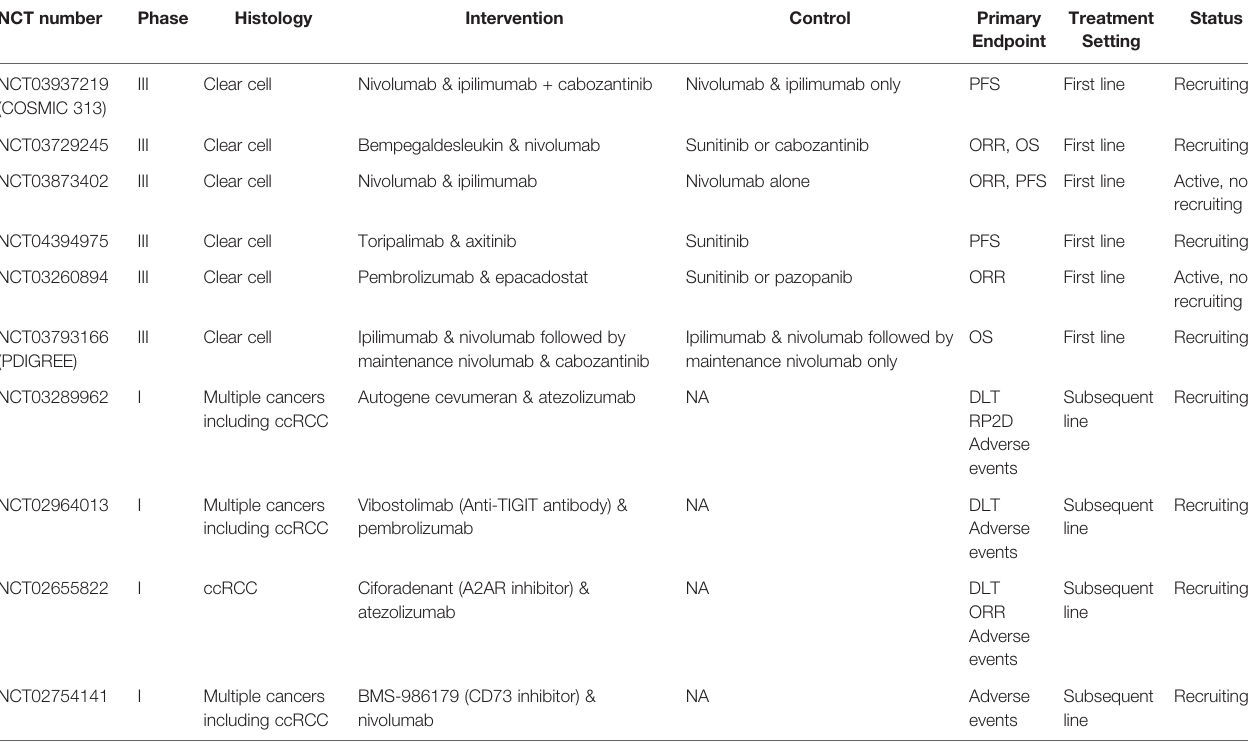
TABLE 2 | Current clinical trials investigating the use of immune checkpoint inhibitor with targeted agents in metastatic